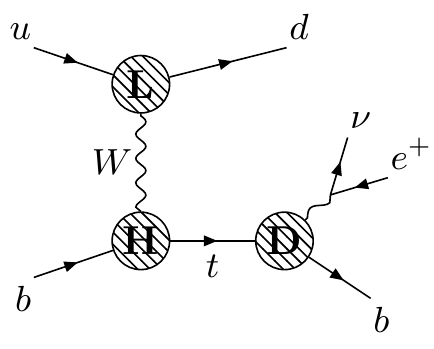
Figure 1 . Feynman diagram for t -channel production in the on-shell approximation with blobs denoting vertex corrections on the light line (L), on the heavy line in production (H) and in de- cay (D).